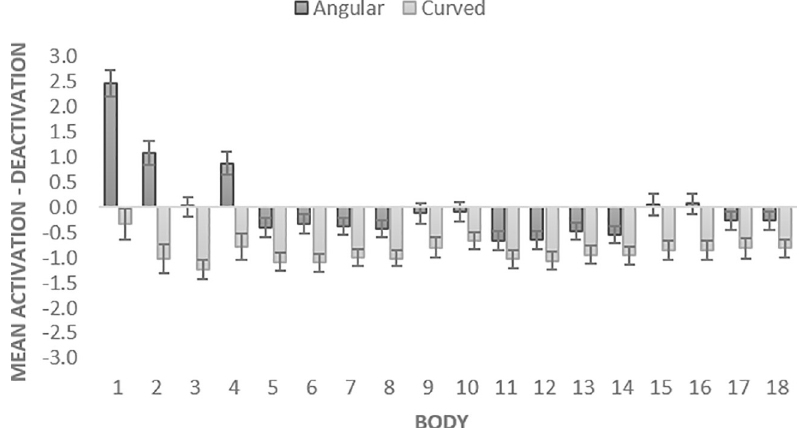
Fig 4. Activation-deactivation in bodily sensations evoked by angular vs. curved pills in Study 1. The bars represent SE.